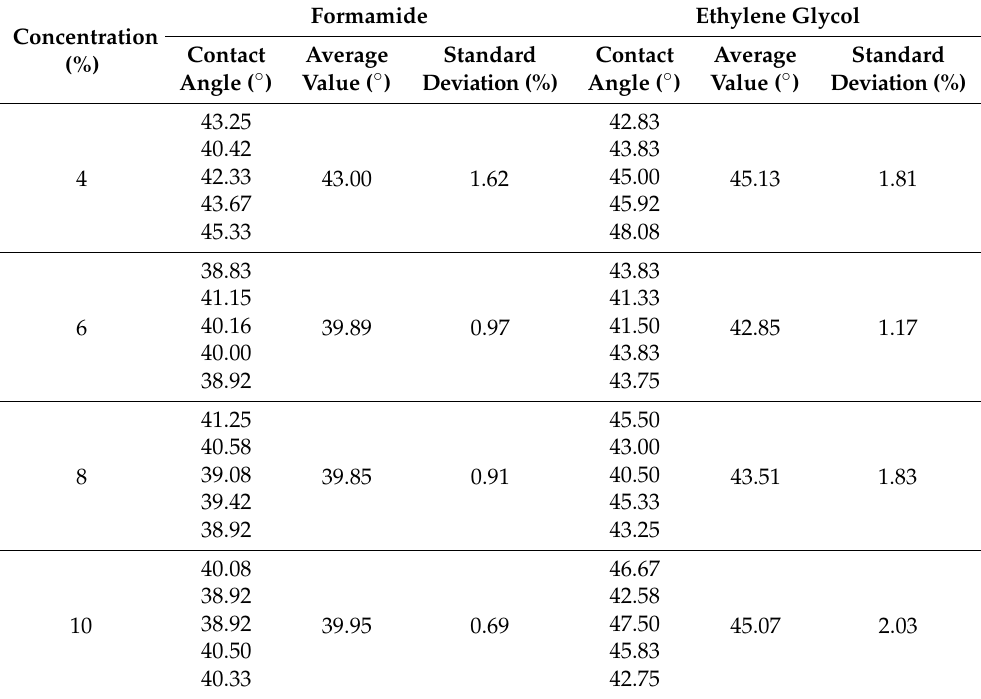
Table 6. Contact angle values of plant consolidation with different concentrations. Formamide Ethylene Glycol Concentration Contact Average Standard Contact Average Standard (%) Angle ( ◦ ) Value ( ◦ ) Deviation (%) Angle ( ◦ ) Value ( ◦ ) Deviation (%) 43.25 42.83 1.8140.42 43.83 42.33 45.00 43.00 1.62 45.13 4 43.67 45.92